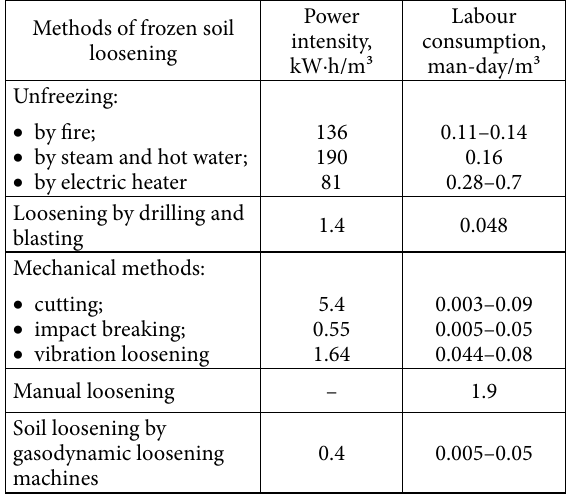
Table 1. Power intensity and labour consumption of frozen soil loosening Methods of frozen soil